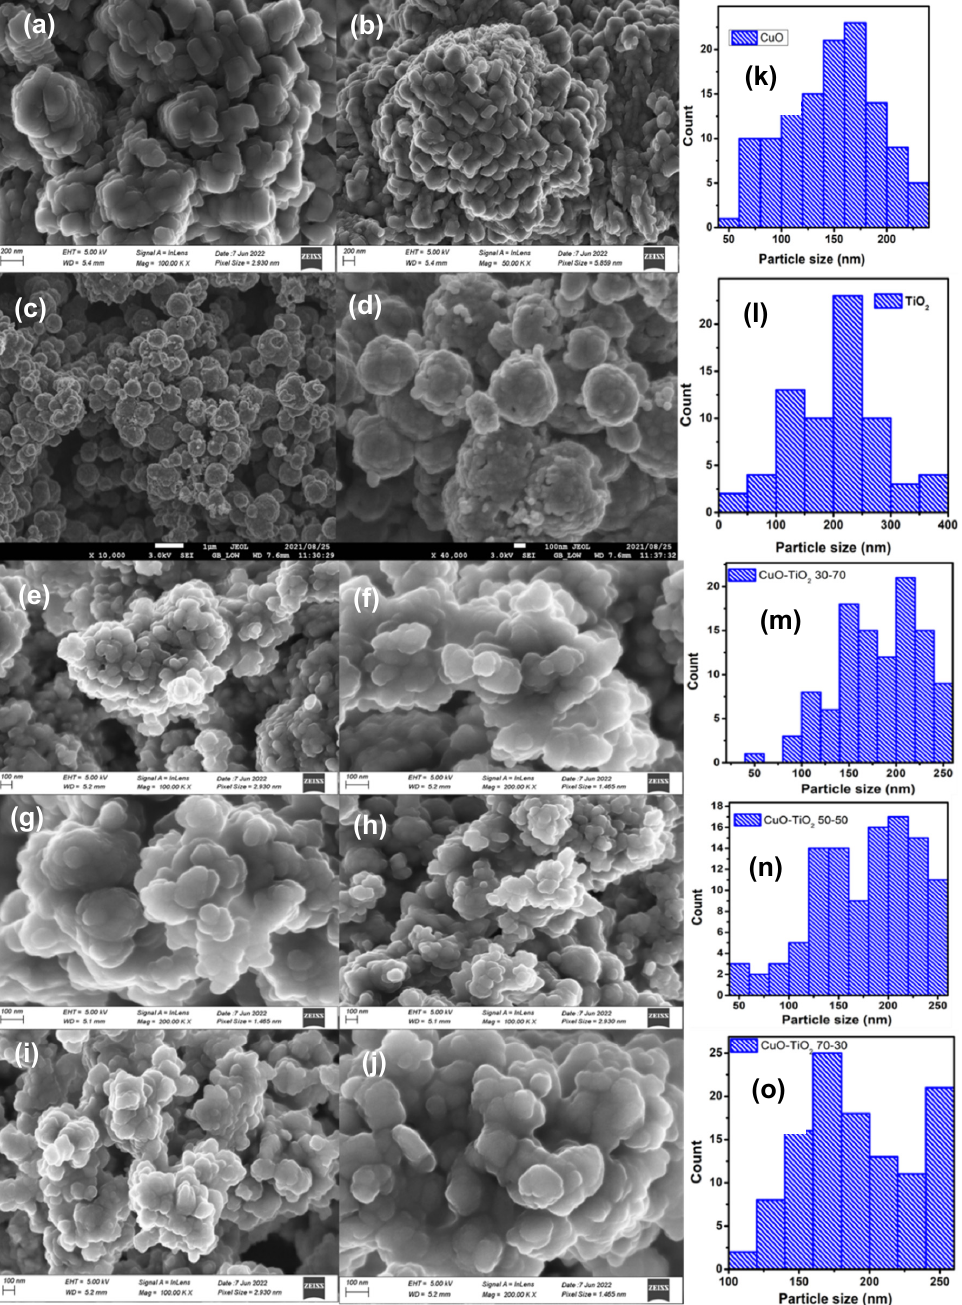
Figure 4. ( a – j ) SEM images for TiO 2 , CuO, and CuO-TiO 2 (30/70, 50/50, and 70/30) and their ( k – o ) particle size distributions.